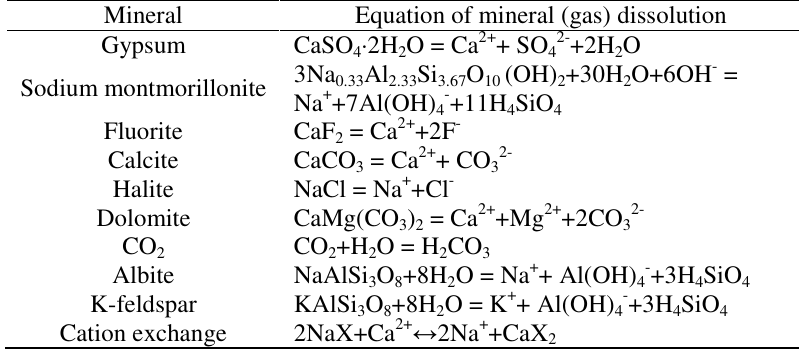
Table 2. Equations of mineral (gas)